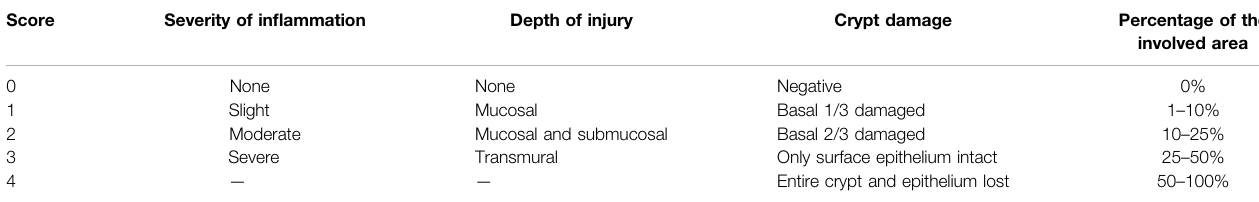
TABLE 3 | Histological scoring system.